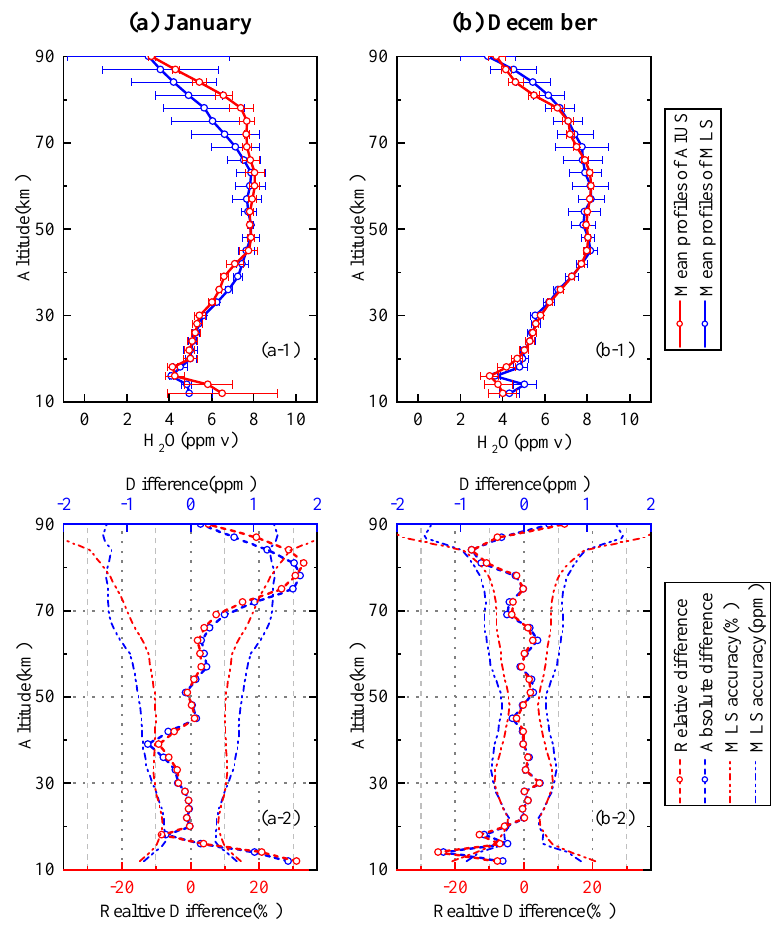
Figure 12. A comparison of H 2 O profiles between AIUS and MLS for 60 ◦ –65 ◦ S in January and December: ( a-1 ) mean profile and standard deviation in January of AIUS and MLS; ( a-2 ) relative difference and absolute difference of mean H 2 O profiles between AIUS and MLS with MLS accuracy; Subfigure ( b ) is same as subfigure ( a ) except for